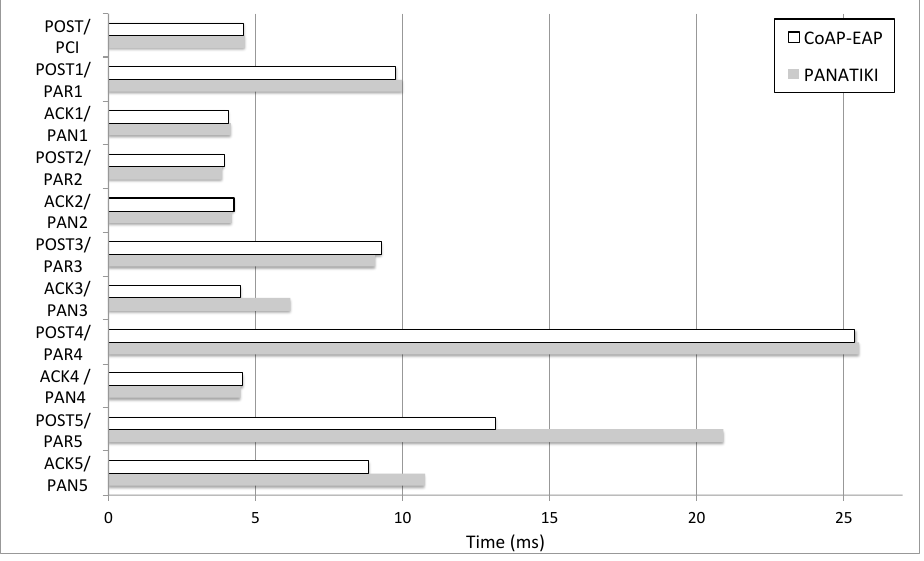
Figure 11. Contiki message processing